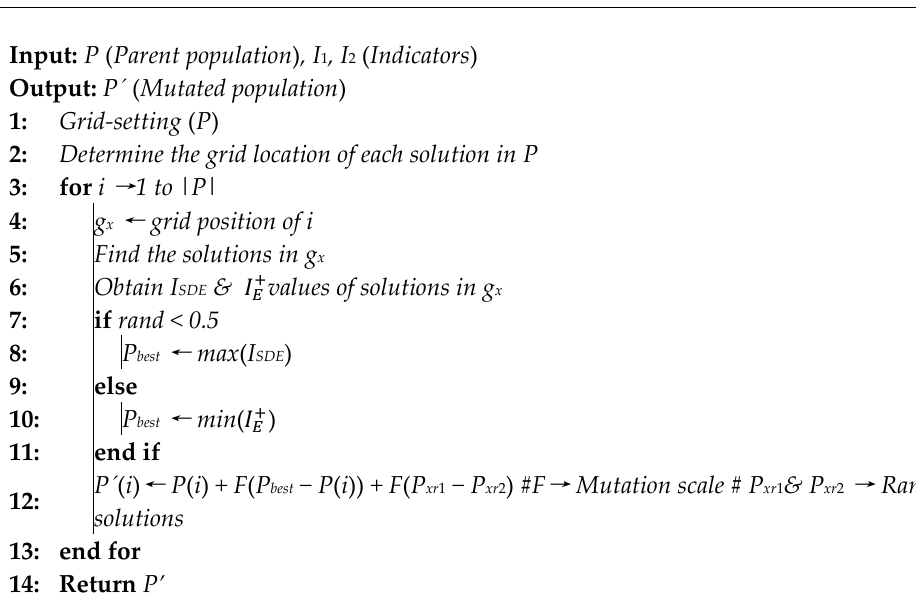
Algorithm 2: Grid-based mutation